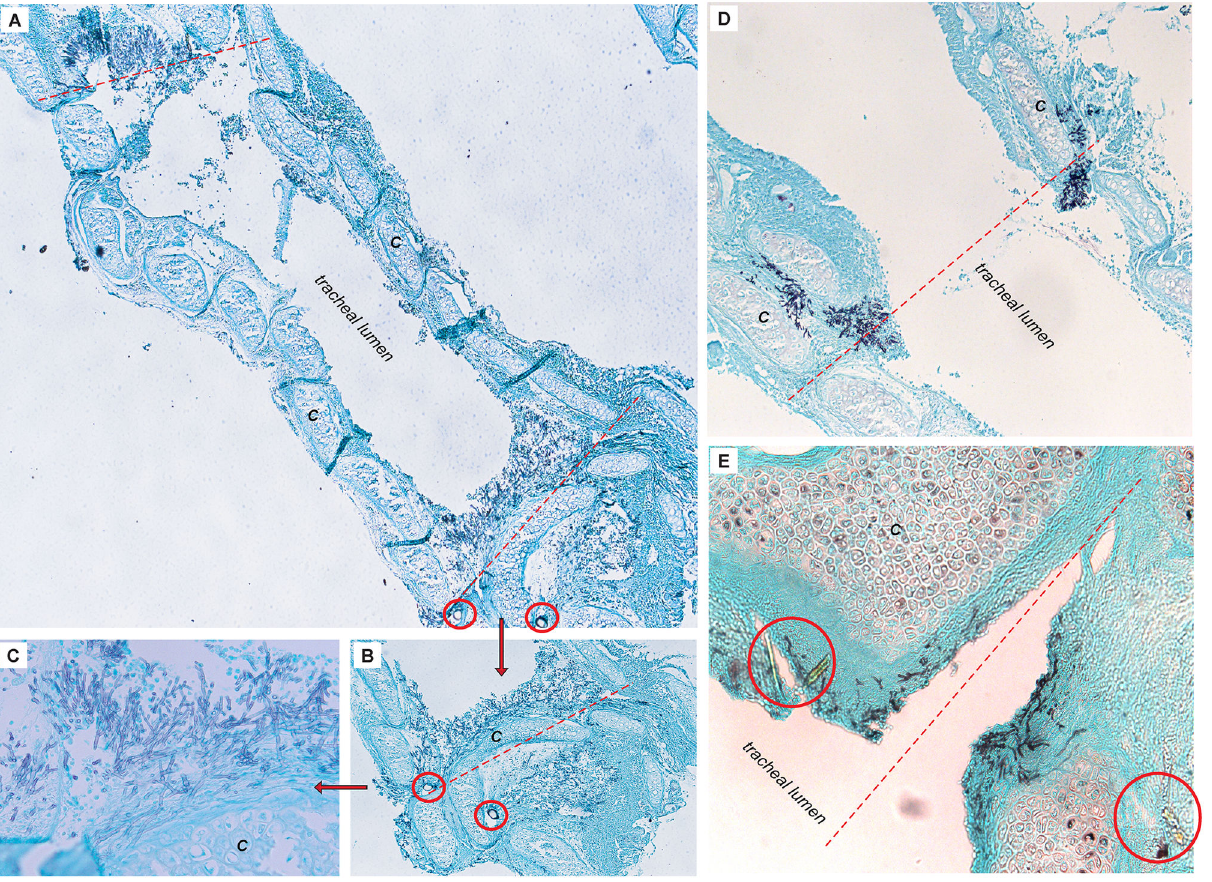
Figure 2. Predilection for anastomotic infection is independent of route of infection or transplant type. ( A ) Grocott’s methenamine silver stained histopathology of longitudinal section for a syngeneic (B6B6) animal infected with A. fumigatus by direct tracheal inoculation. Infection localized to both anastomoses (red dotted lines). Suture material (red circles) can be seen at inferior anastomosis (original magnification 5X). “ C ” denotes tracheal cartilaginous ring. ( B ) Syngeneic transplant inferior anastomosis, demonstrating aggressive abluminal invasion of fungus (20X magnification). ( C ) Syngeneic transplant inferior anastomotic infection (40X magnification). ( D ) Allogeneic animal (BALB/cB6) infected by intra-tracheal injection, demonstrating an aggressive infection at the anastomosis (red dotted line) (10X magnification). ( E ) Dehiscence of donor-recipient anastomosis in allogeneic animal